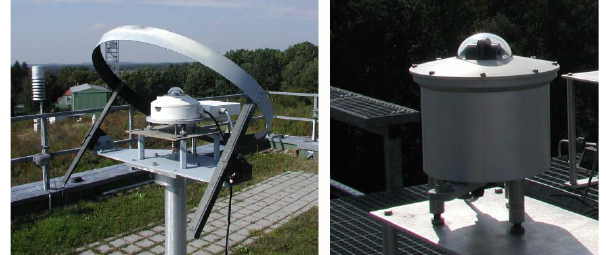
Figure 1. Shaded pyranometer (left picture) and Scanning Pyrhe- liometer / Pyranometer (right) on the radiation measurement plat- form at Lindenberg observatory.